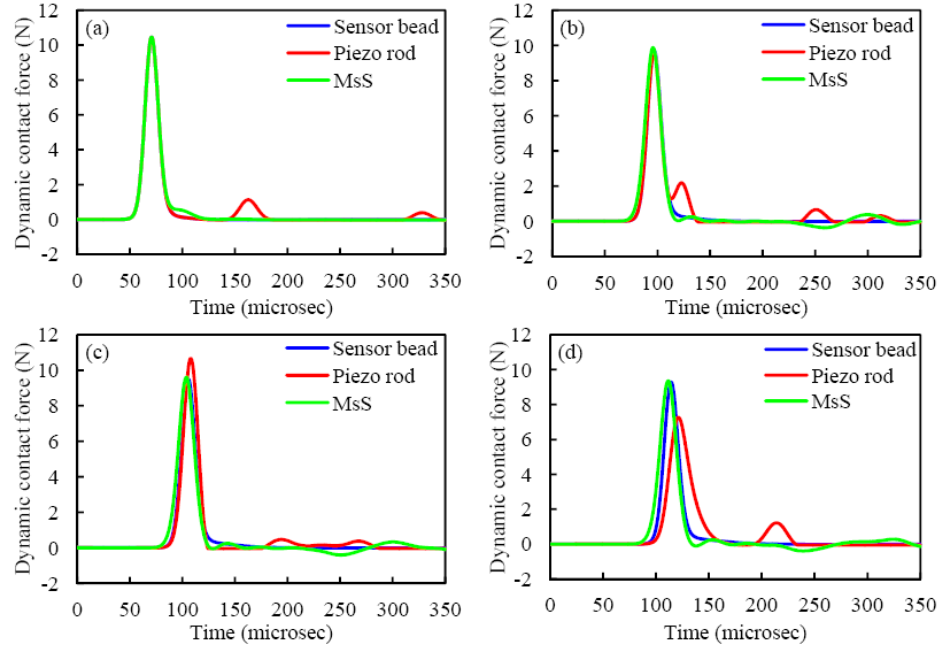
Figure 4. Discrete particle model results showing the temporal force profile for all three sensing configurations at contact points: ( a ) c 8 , ( b ) c 11 , ( c ) c 12 , and ( d ) c 13 .